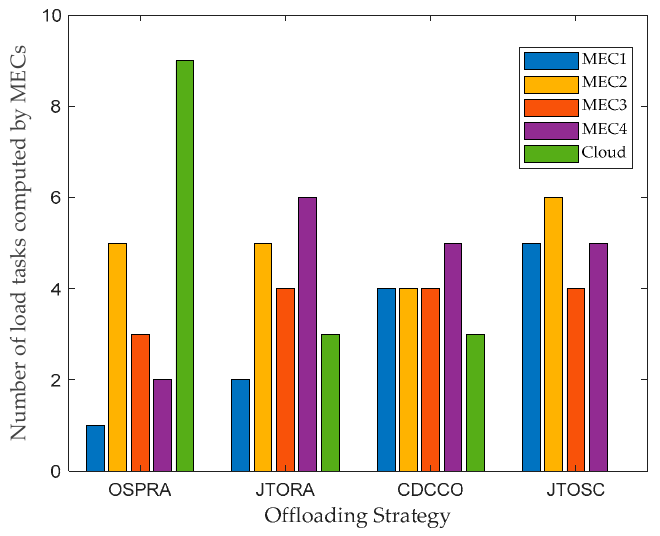
Figure 6. Comparison of the number of load tasks computed by MECs with different strategies.